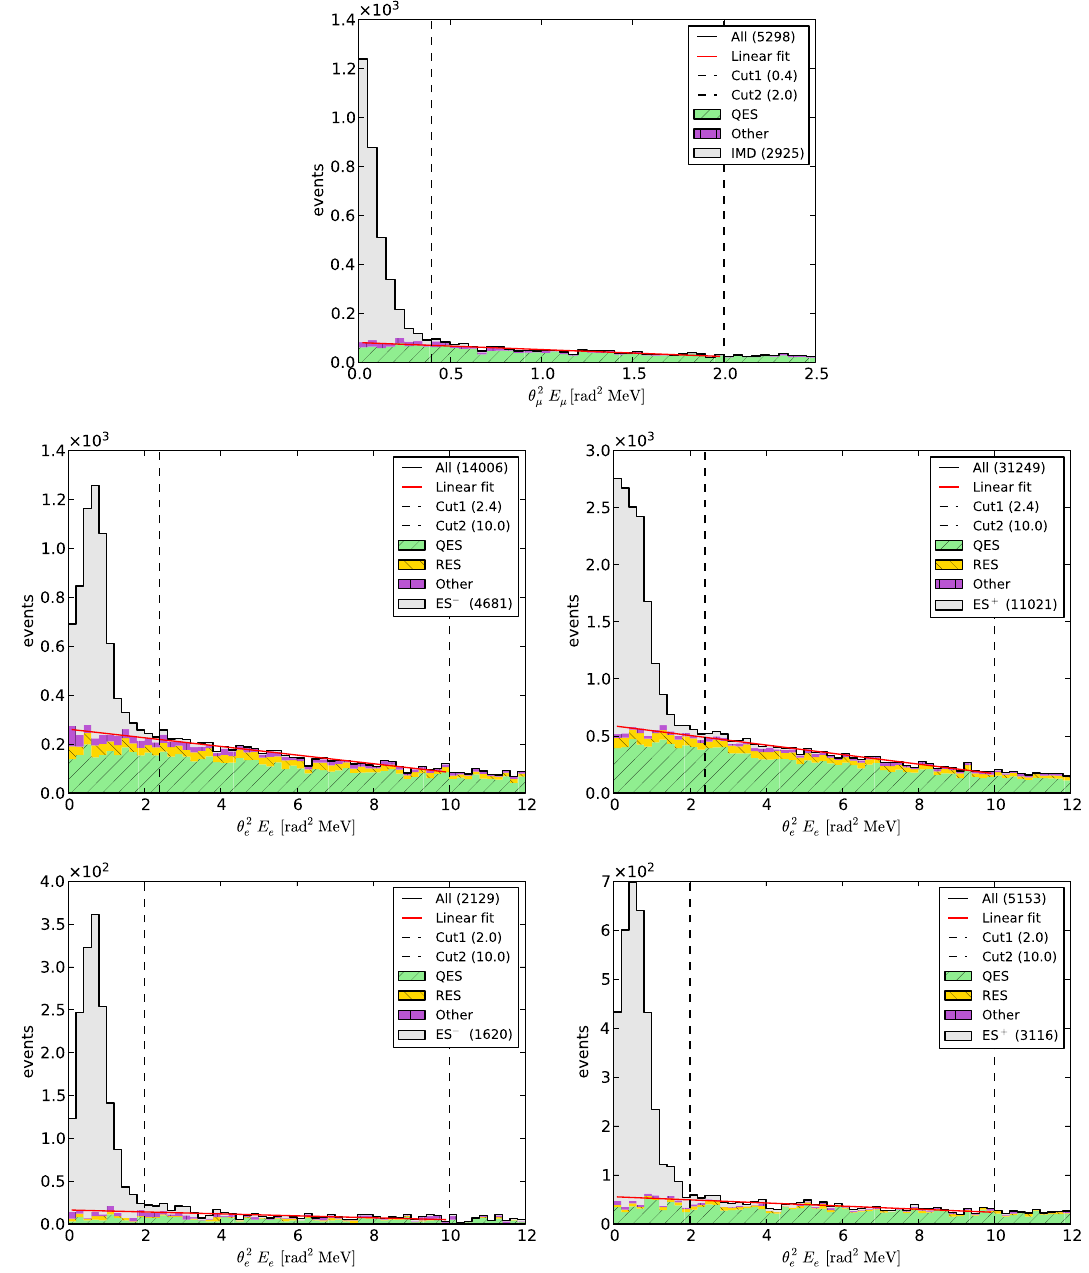
FIG. 11. Distributions over (cid:1) 2 ‘ E ‘ for the different event samples considered. In each histogram the distribution of the leptonic events is filled with solid grey, the distribution of the hadronic events is hatched, and the total spectrum is the black histogram. The two cuts bounding the fit interval are drawn with dashed lines. The red line indicates the background extrapolation. The top three histograms refer to the 25 GeV scenario: IMD sample (top), ES (cid:1) sample (middle left), and ES þ sample (middle right), while the bottom two are for the 10 GeV neutrino factory: ES (cid:1) sample on the bottom left and ES þ sample on the bottom